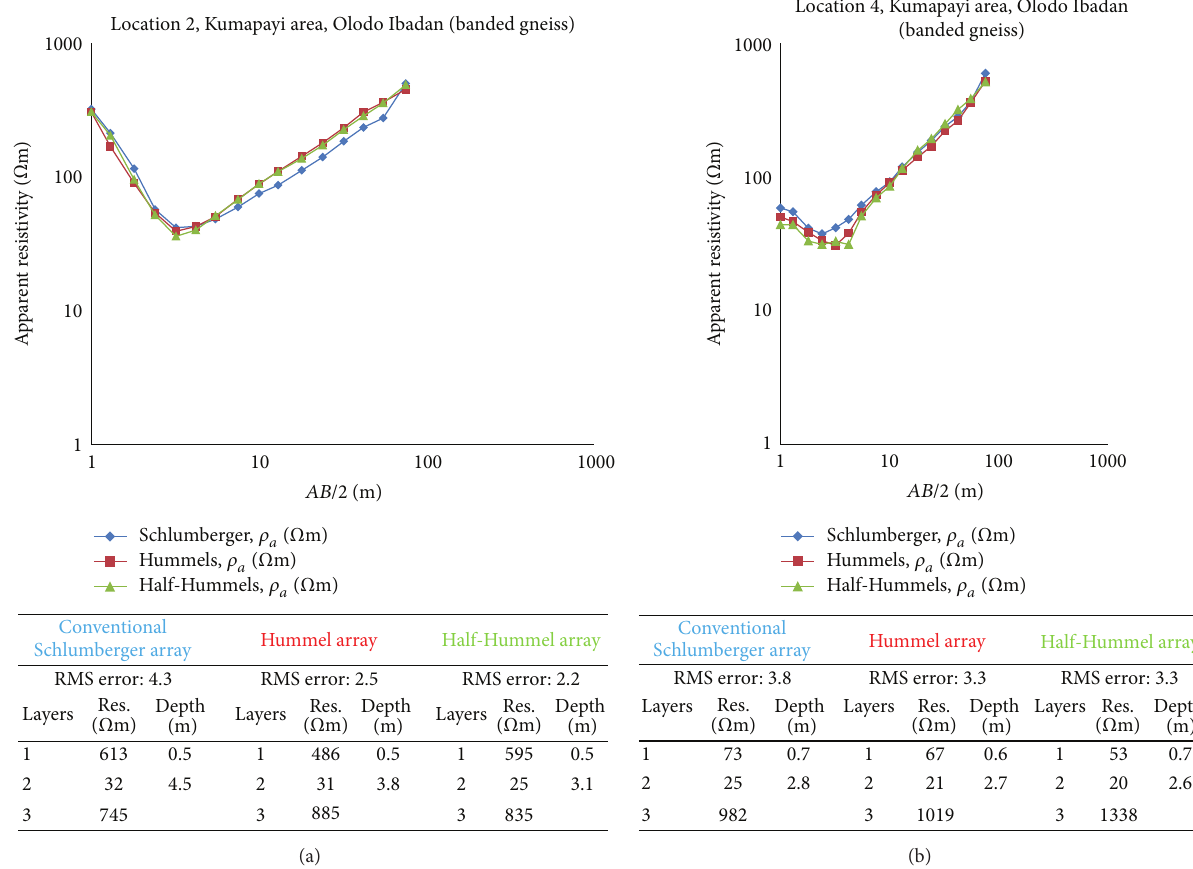
Figure 11: Comparison of results obtained from the interpretation of field data collected using the different array methods at VES stations on banded gneiss for (a) location 2, Olodo Ibadan, and (b) location 4, Olodo Ibadan.